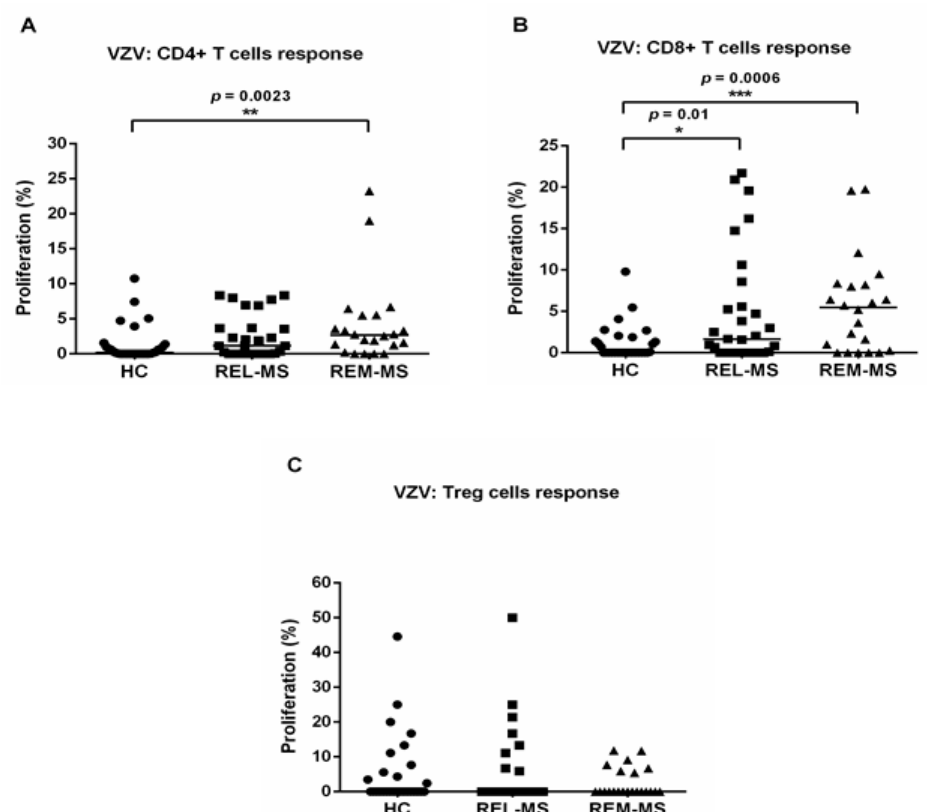
Figure 1. T cell response of REL-MS ( n = 29), REM-MS ( n = 22) and HC ( n = 32) to stimulation with VZV. Proliferation of CD4+ T cells was significantly higher in REM-MS patients compared to HC ( A ). CD8+ T cells from MS patients (REL-MS and REM-MS) showed a higher proliferative response compared to HC ( B ) and there was no significant difference in Treg cell response between the three groups ( C ). Data are presented as the mean of proliferation percentage. Each dot represents one subject, and horizontal bars correspond to the median values. * p < 0.05, ** p < 0.01, *** p < 0.001.